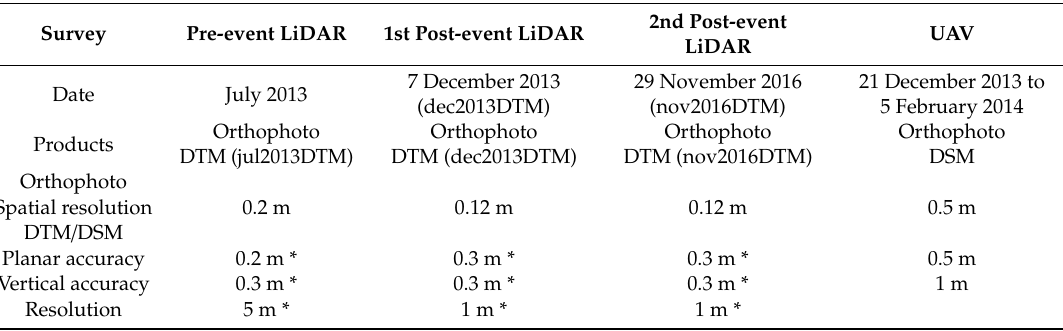
Table 4. Summary of LiDAR and UAV